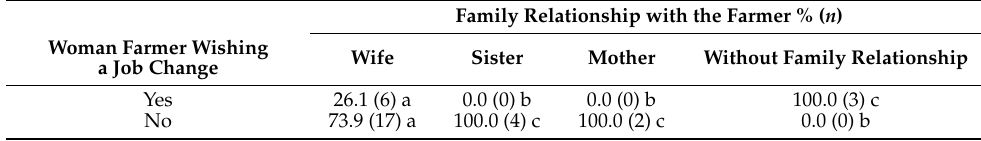
Table 5. Family workforce vs. women with a job change to anyone different from dairy goat farming. Family Relationship with the Farmer % ( n ) Woman Farmer Wishing Sister Mother Without Family Relationship a Job Change Wife Yes 26.1 (6) a 0.0 (0) b 0.0 (0) b 100.0 (3) c No 73.9 (17) a 100.0 (4) c 100.0 (2) c 0.0 (0) b Values with different letters in the same row are different ( p < 0.05).